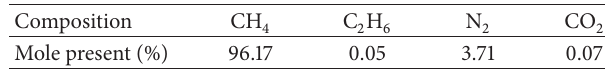
Table 3: Composition of